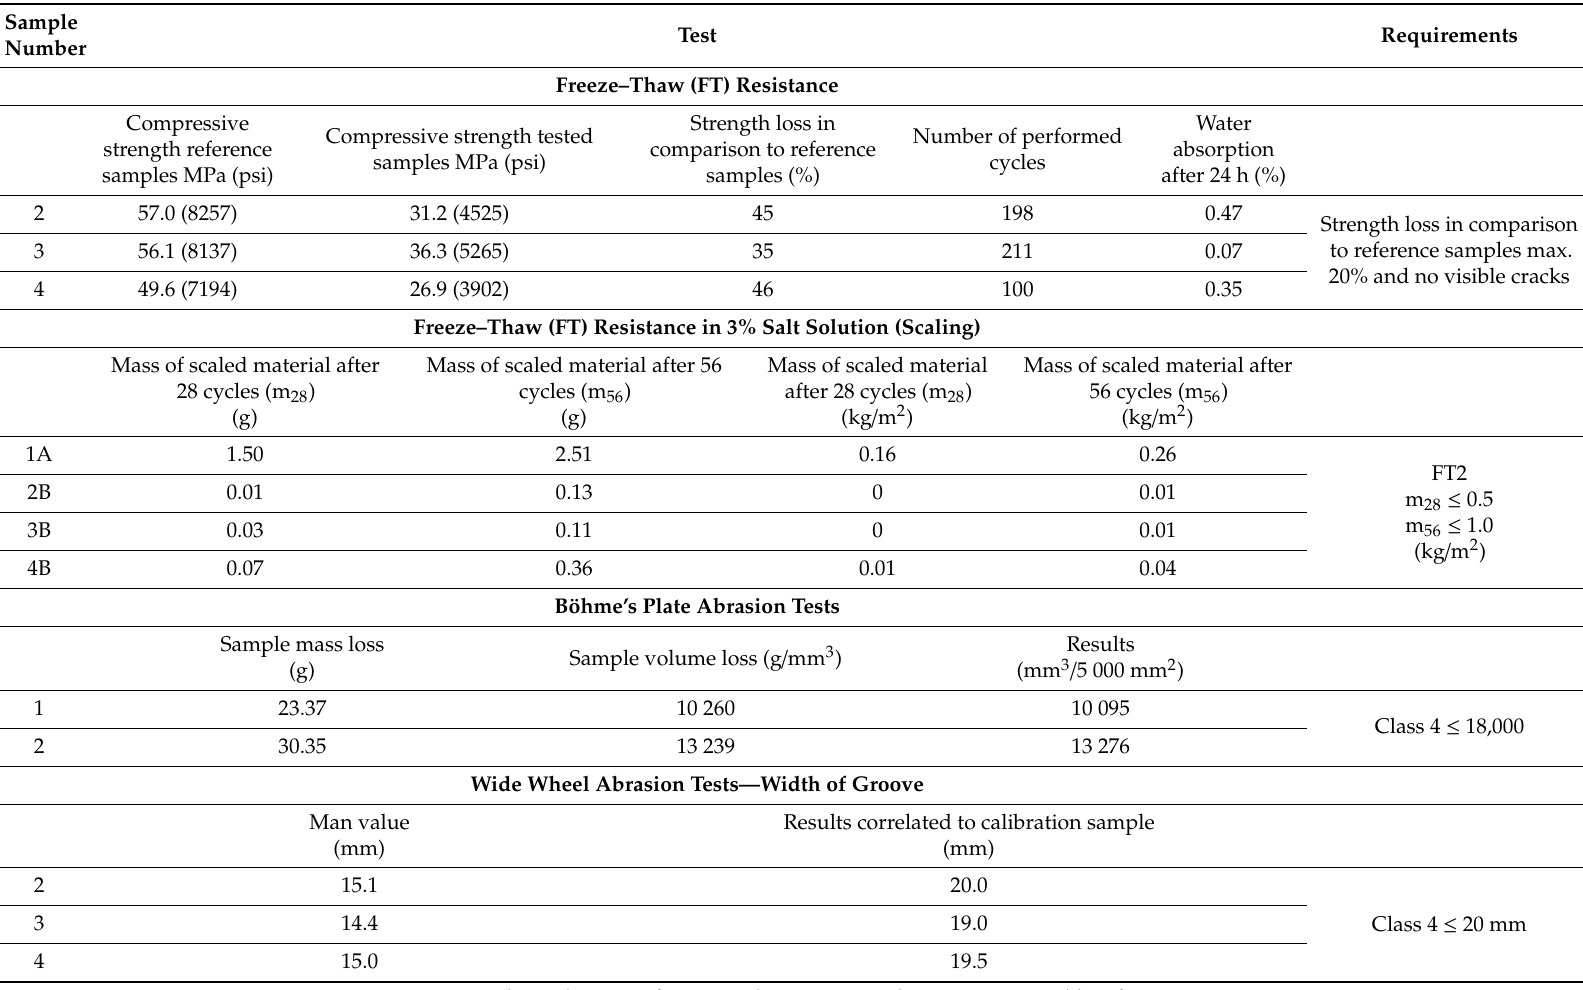
Table 6. Durability of sulfur